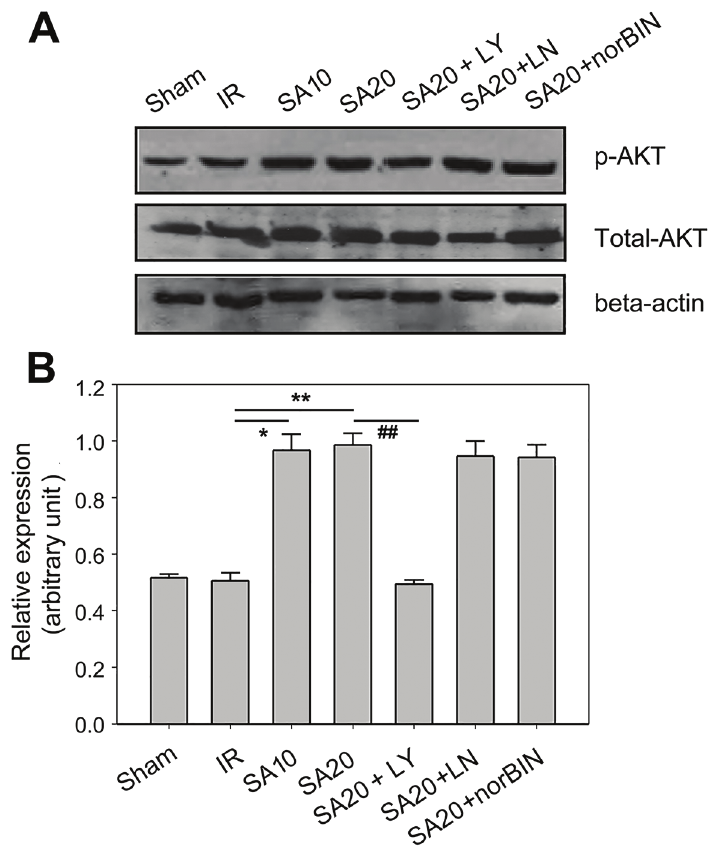
Figure 7. Determination of the expression of p-AKT in different treatment groups after cerebral cortex ischemia. SA10, SA20, SA20 + LY294002, SA20 + L-NAME, SA20 + norBIN were adminis- tered and western blot assay was performed to detect the expression of p-AKT. A , Represent- ative immunoblotting images among different treatment groups are shown. B , Absorbance analysis of the expression of p-AKT. Data are reported as means ± SD. *P o 0.05, **P o 0.01 compared to the IR (DMSO) group, ## P o 0.01 compared to the salvinorin A2 treatment group. The expression of p-AKT was analyzed by one-way ANOVA followed by Tukey ’ s test. LY: LY294002 (10 m M, injected topically); LN: L-NAME (10 m M, injected topically); IR (ischemia reperfusion control, DMSO): 1 m L/kg ( iv ); SA10: salvinorin A (10 m g/kg, iv ); SA20: salvinorin A (20 m g/kg, iv ); norBIN: norbinaltorphimine 1 m M (injected